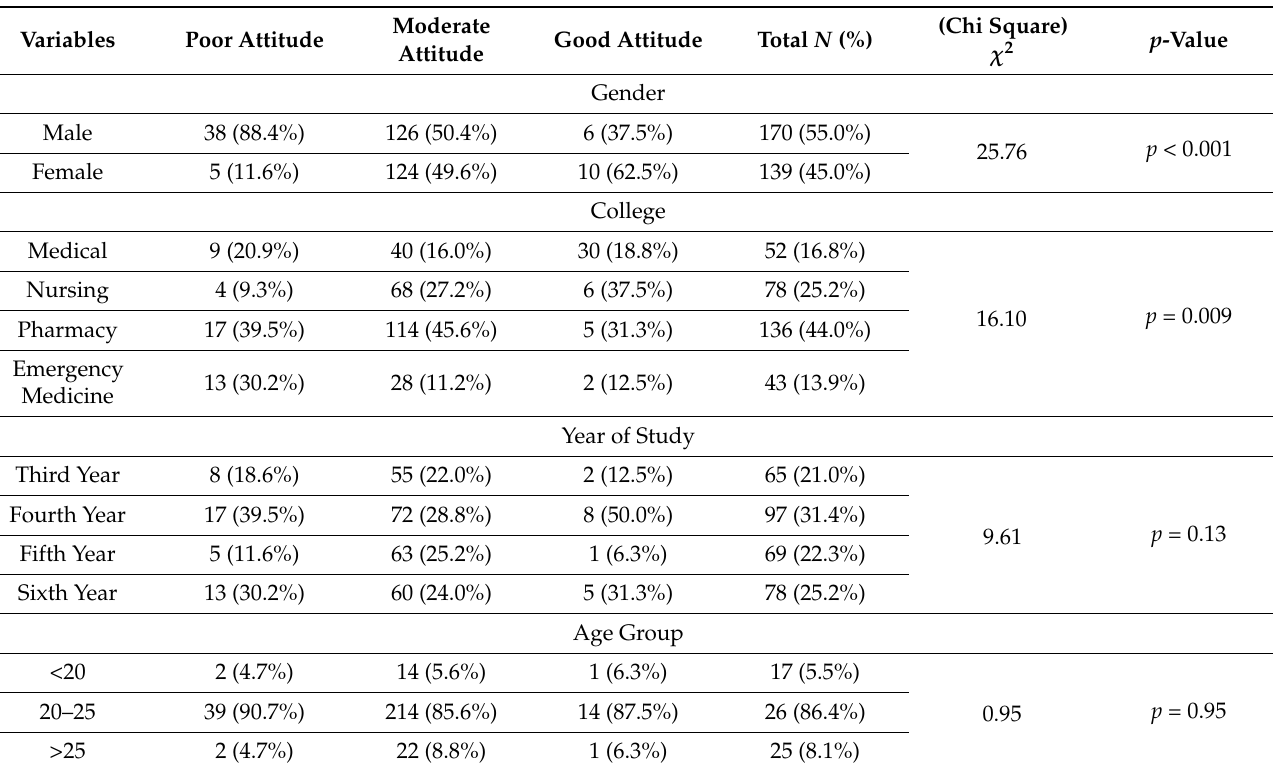
Table 8. Cross-tabulations between the participants’ demographics and the attitude